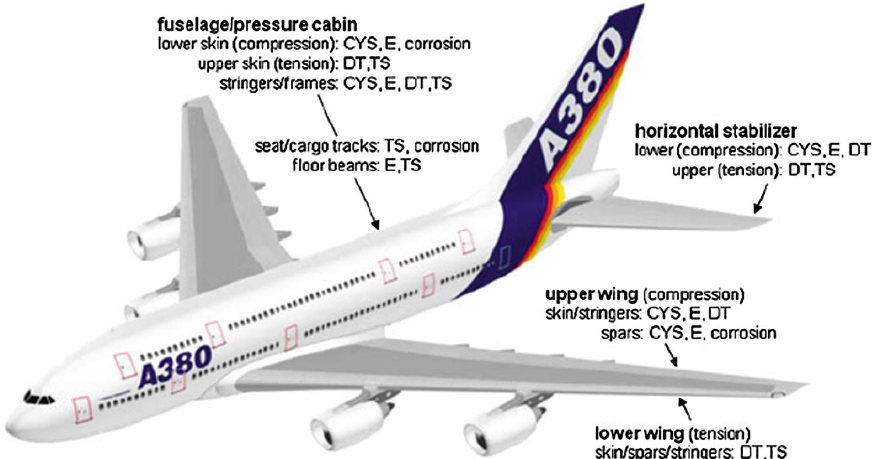
Figure 3. The application of Al alloys in aircraft. Reprinted from Ref. [10] with permission. Copyright 2018, Elsevier.